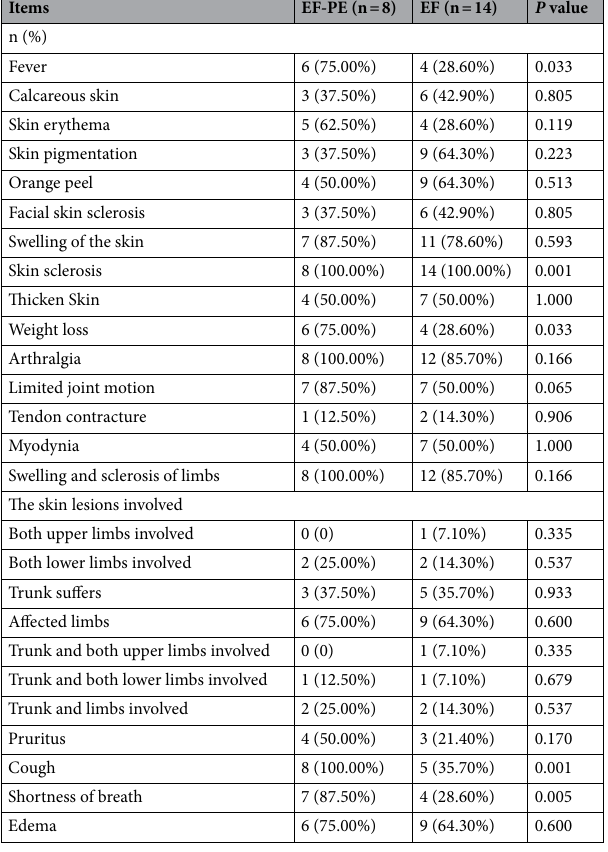
Table 2. Clinical manifestations of the two groups. Comparisons were determined by chi-square test or Fisher’s exact test. P < 0.05 was considered statistically